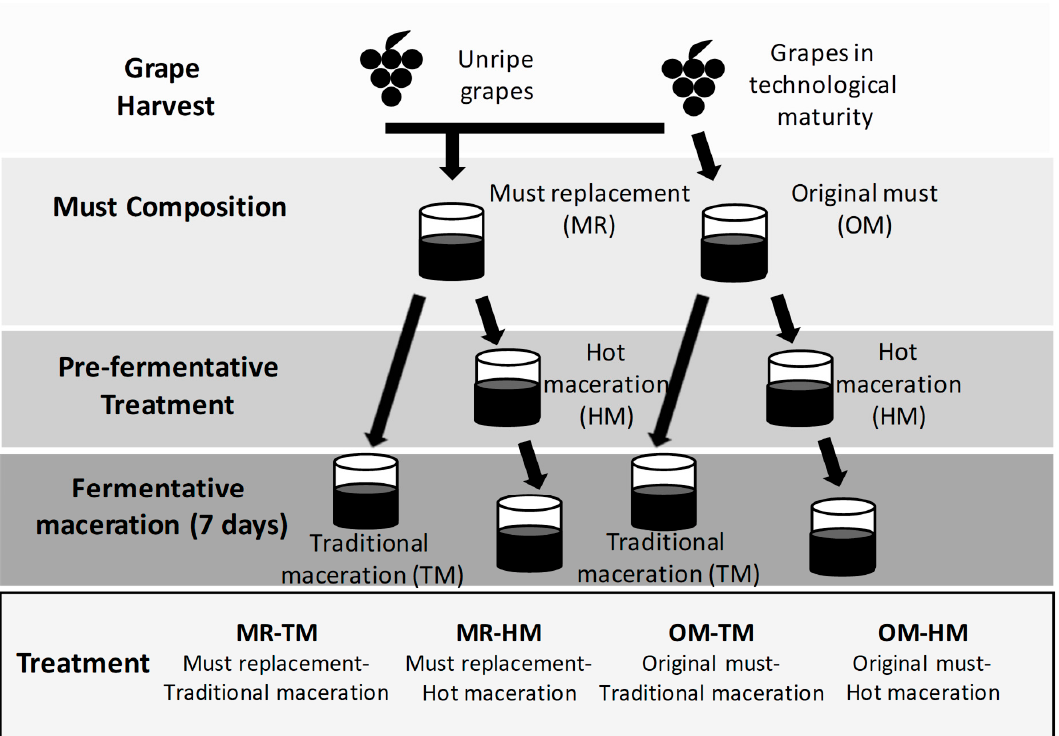
Figure 1. Diagram of the experimental design.